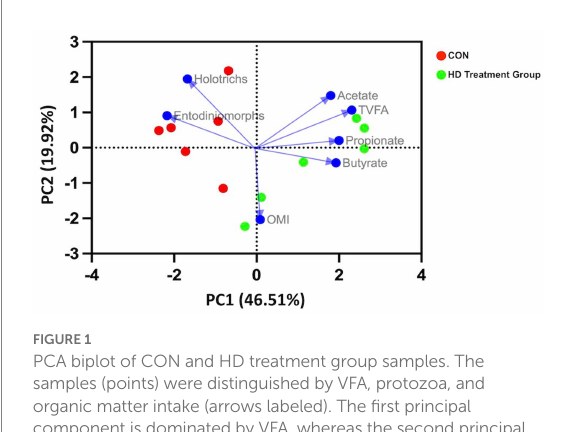
FIGURE 1 PCA biplot of CON and HD treatment group samples. The samples (points) were distinguished by VFA, protozoa, and organic matter intake (arrows labeled). The first principal component is dominated by VFA, whereas the second principal component is dominated by organic matter